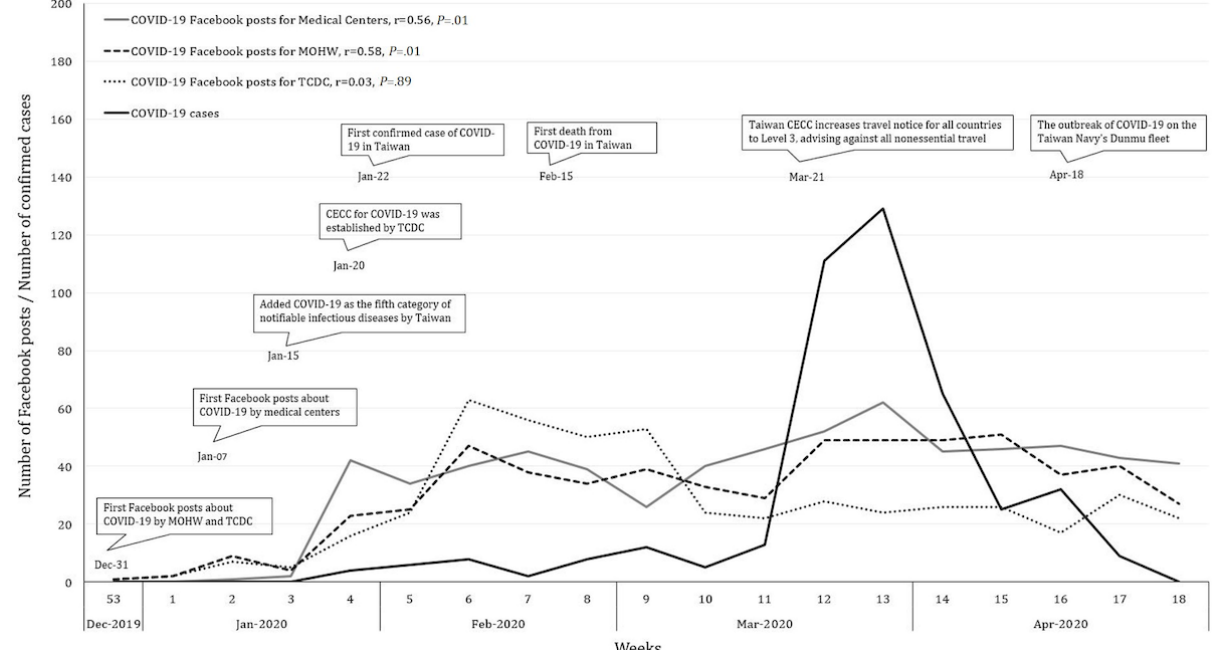
Figure 1. COVID-19 confirmed cases per week in Taiwan and Facebook posts per week by the MOHW, TCDC, and nationwide medical centers from December 2019 to April 2020. CECC: Central Epidemic Command Center; MOHW: Ministry of Health and Welfare; TCDC: Taiwan’s Center for Disease Control.